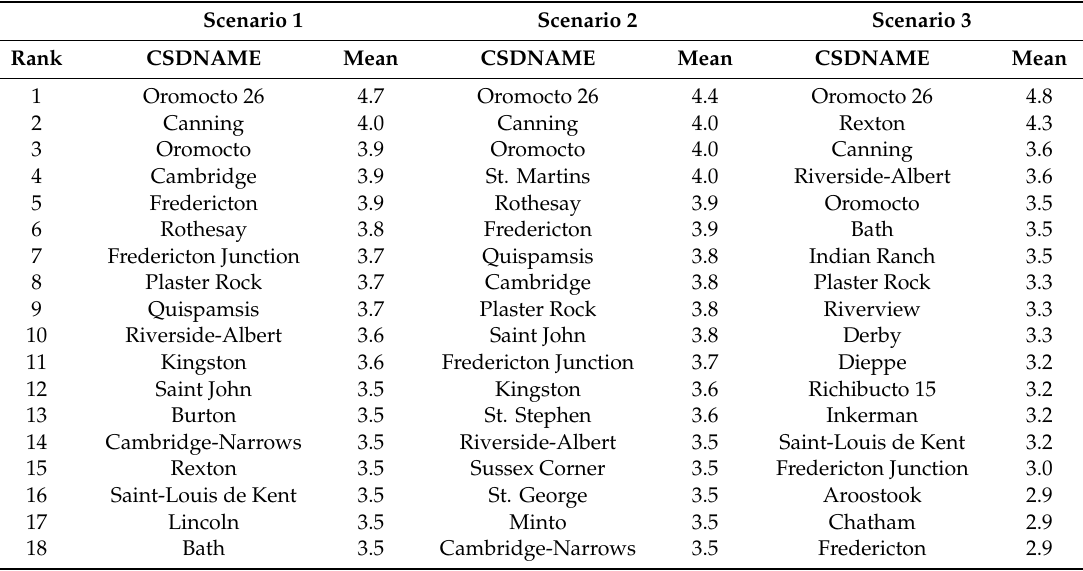
Table 5. Prioritization list based on zonal Statistics with a very high